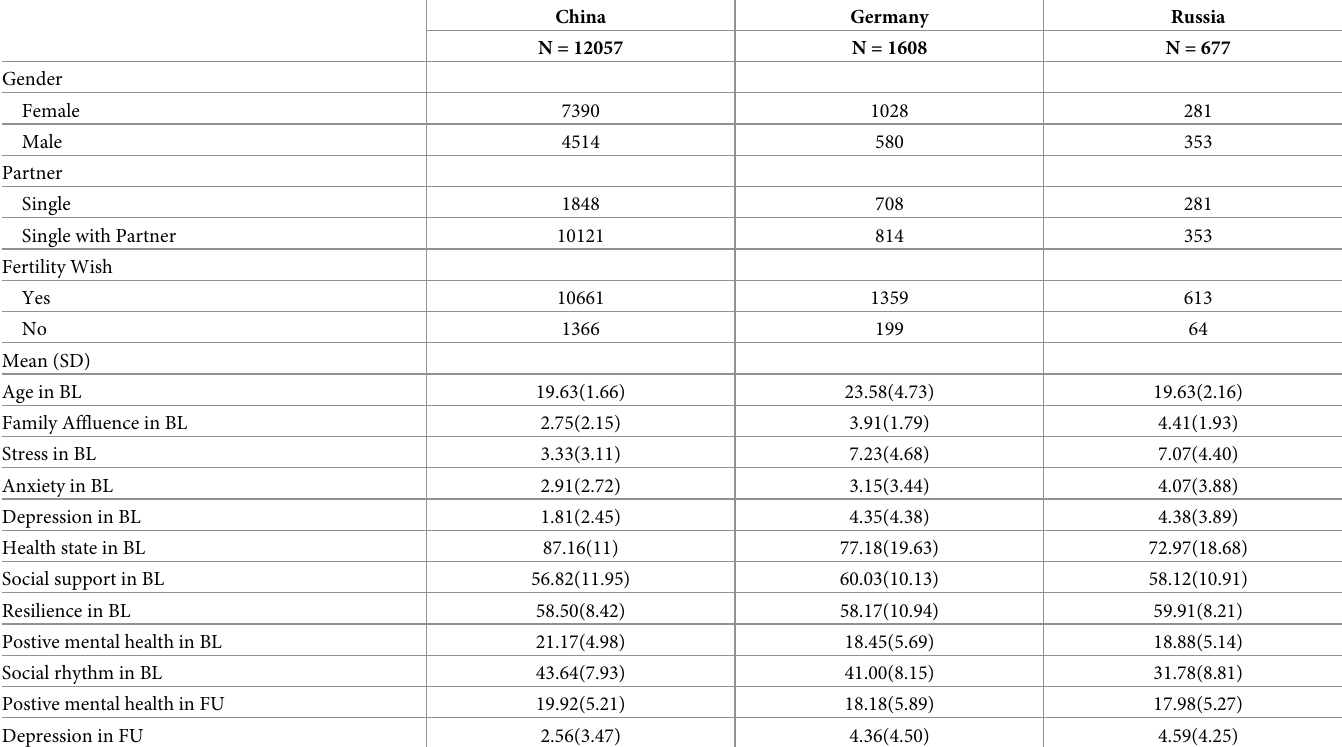
Table 1. Descriptive statistics of socio-demographic variables and